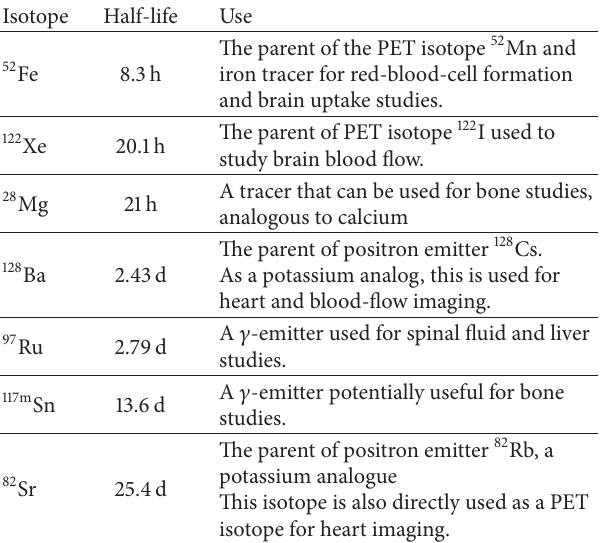
Table 1: Medical isotopes relevant to IsoDAR energies, reprinted from